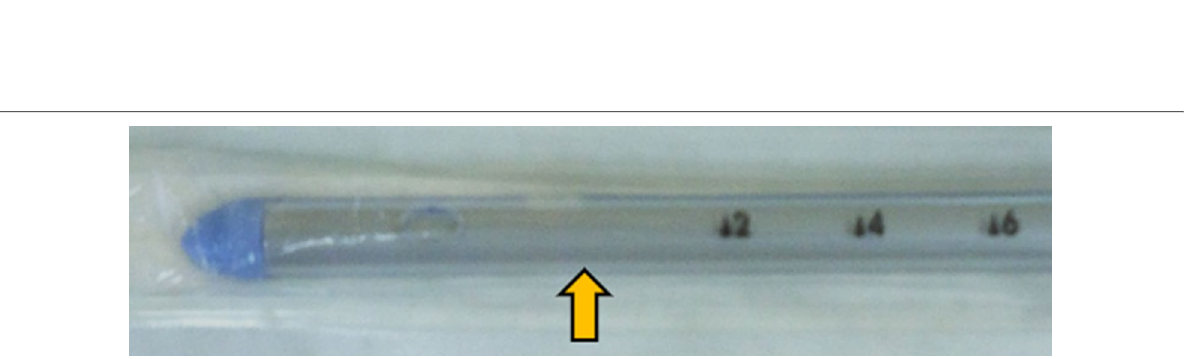
Fig.3 Patient with Covid-19 ARDS after CD insertion for a right ventral pneumothorax. The linear transducer shows the transverse plane of the CD between the enhancing pleural layers under the anterior chest wall next to the rib (left CUS, blue arrow towards the drain position on the right CR). In the same patient, the CDI (here 1.00) is equal to the length of the CD in the chest measured on CR (15.09 cm) divided by the depth of insertion of the CD read directly on a CD scale plus 5 cm (10 5 cm) +